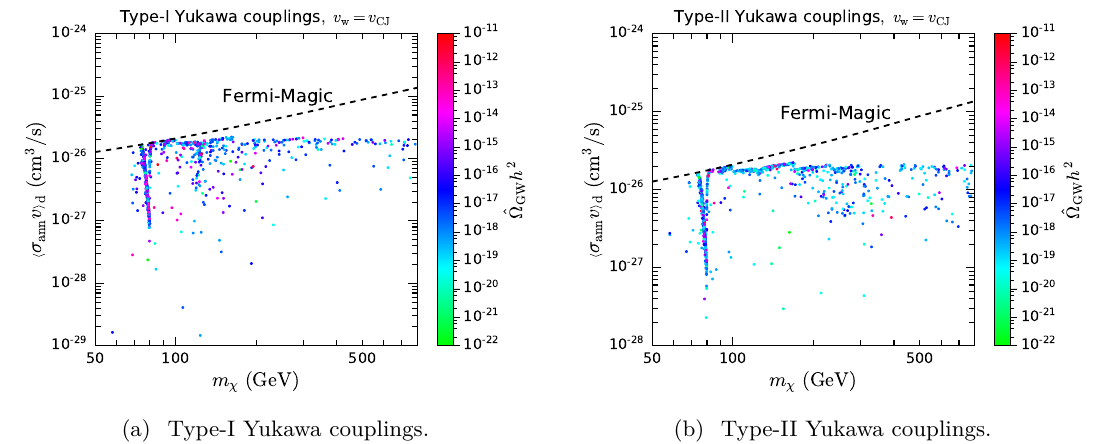
plane for type-I (a) and type-II (b) d